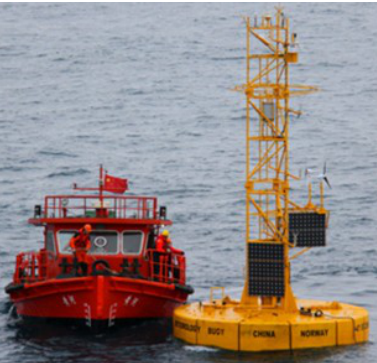
Figure 3. Long-term observation system of air-sea coupling in